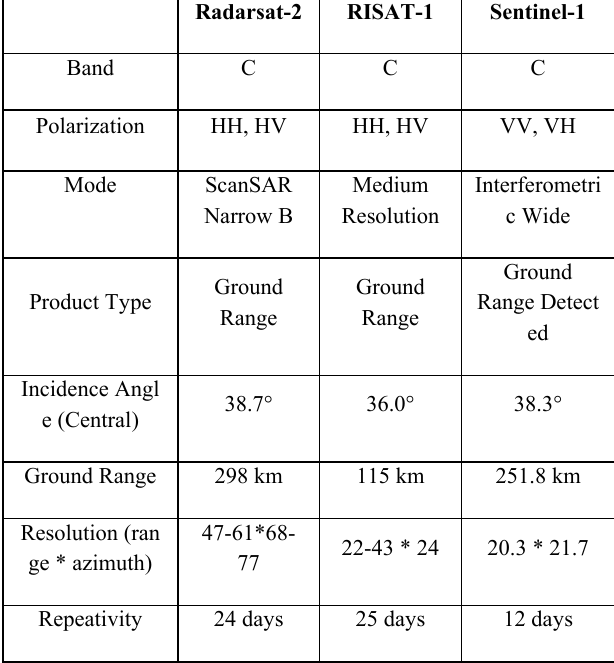
Table 1. Specifications of Satellite based SAR data used for rice area